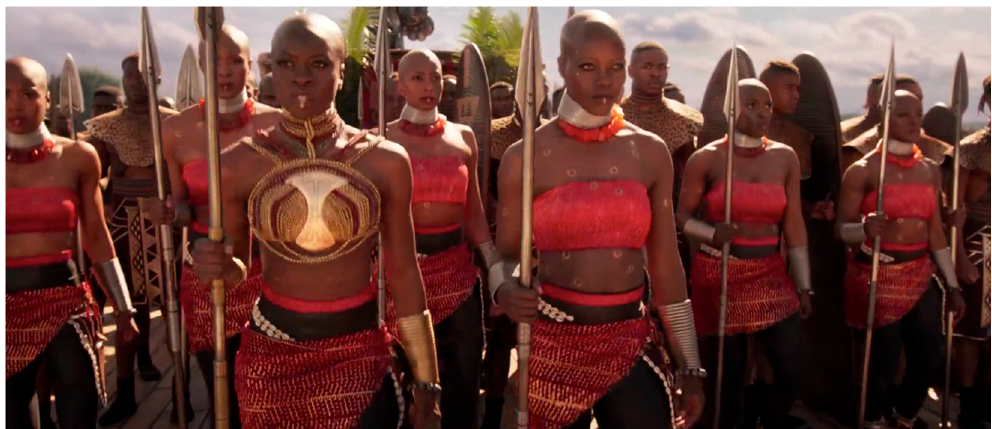
Figure 4. The all-women army led by Okoye who is left front of screen (Taken in accordance with fair use of images rights for the film Black Panther , Ryan Coogler, 2018, Marvel).